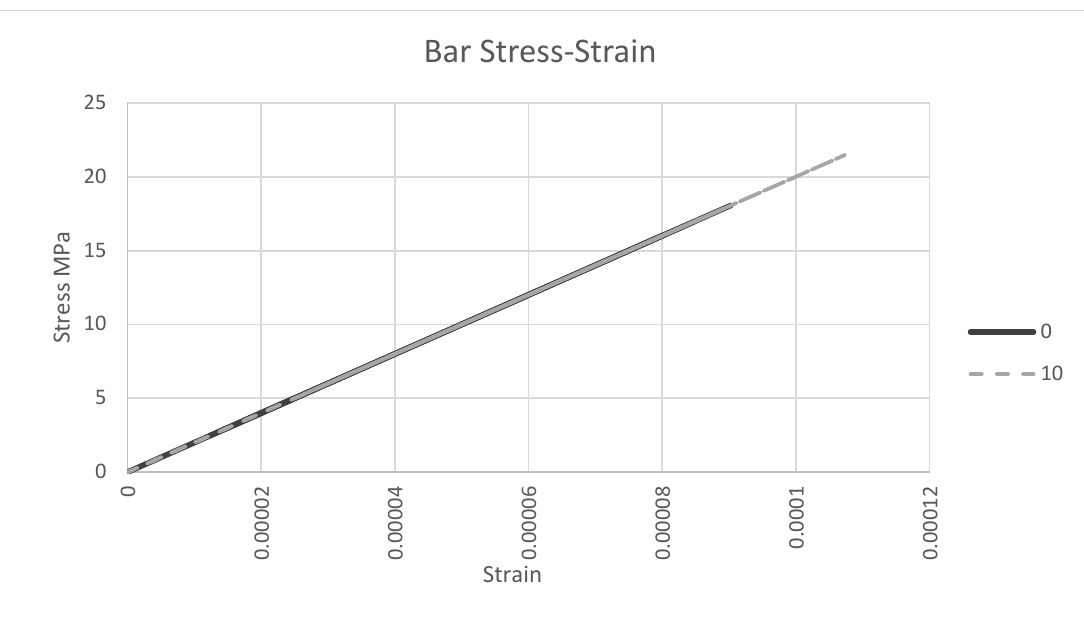
Fig. 10. Comparative stress-strain chart of the cap-beam bars (around the node).